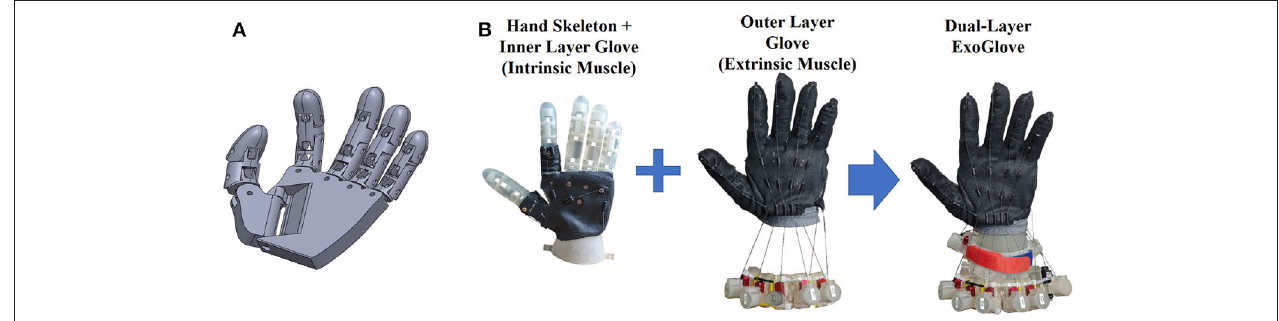
FIGURE 1 | The design and implementation of the robotic hand skeleton in human hand size. (A) The mechanical design of the robotic hand skeleton, with full motion degrees of freedom with the size of human hand. (B) Assembly of the dual-layer exo-glove robotic hand.